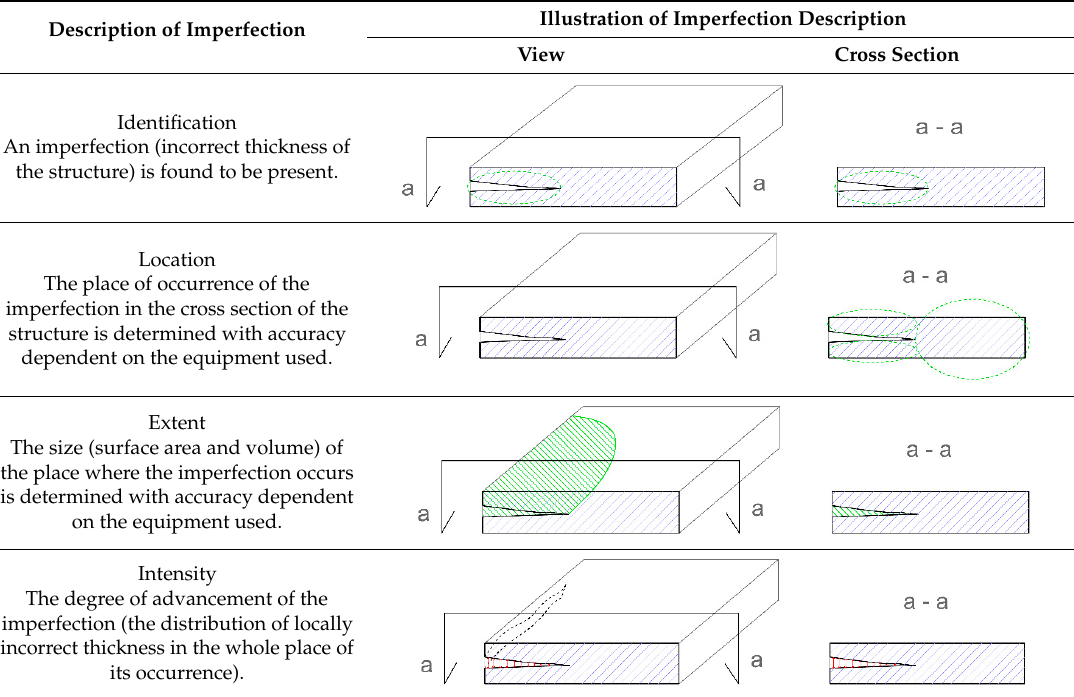
Table 3. Explanation of proposed terms for describing materials imperfection—delamination in concrete structures tested by non-destructive acoustic methods.